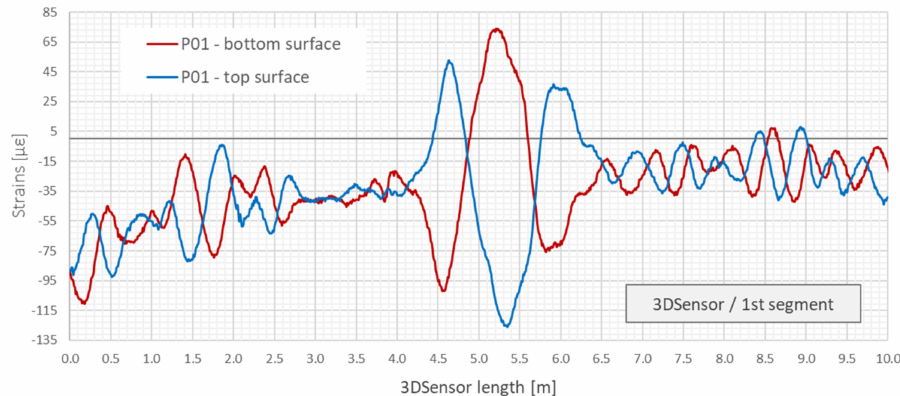
Figure 26. Strain data from the bottom and top surface of 3DSensor in length domain (only first 10 m were selected for clear presentation).